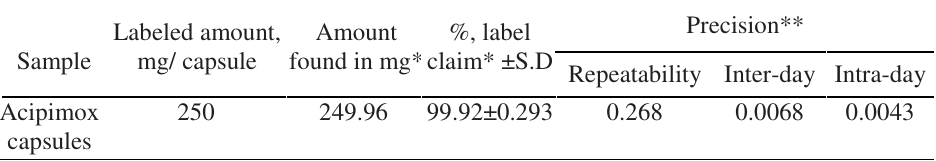
Table 2 . Assay results and precision